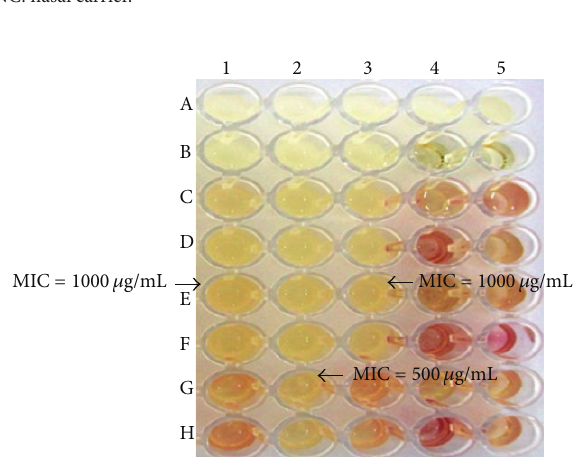
Figure 3: Microwell dilution in broth. Extract: M. spinosum 5:95% AcOEt : HEX. 1: S. aureus ATCC 43300; 2 and 3: MRSA strains isolated from nasal carriers; 4 and 5 (A): extract control; 4 and 5 (B): broth controls; 4 and 5 (C–E): DMSO controls; and 4 and 5 (F–H): strains